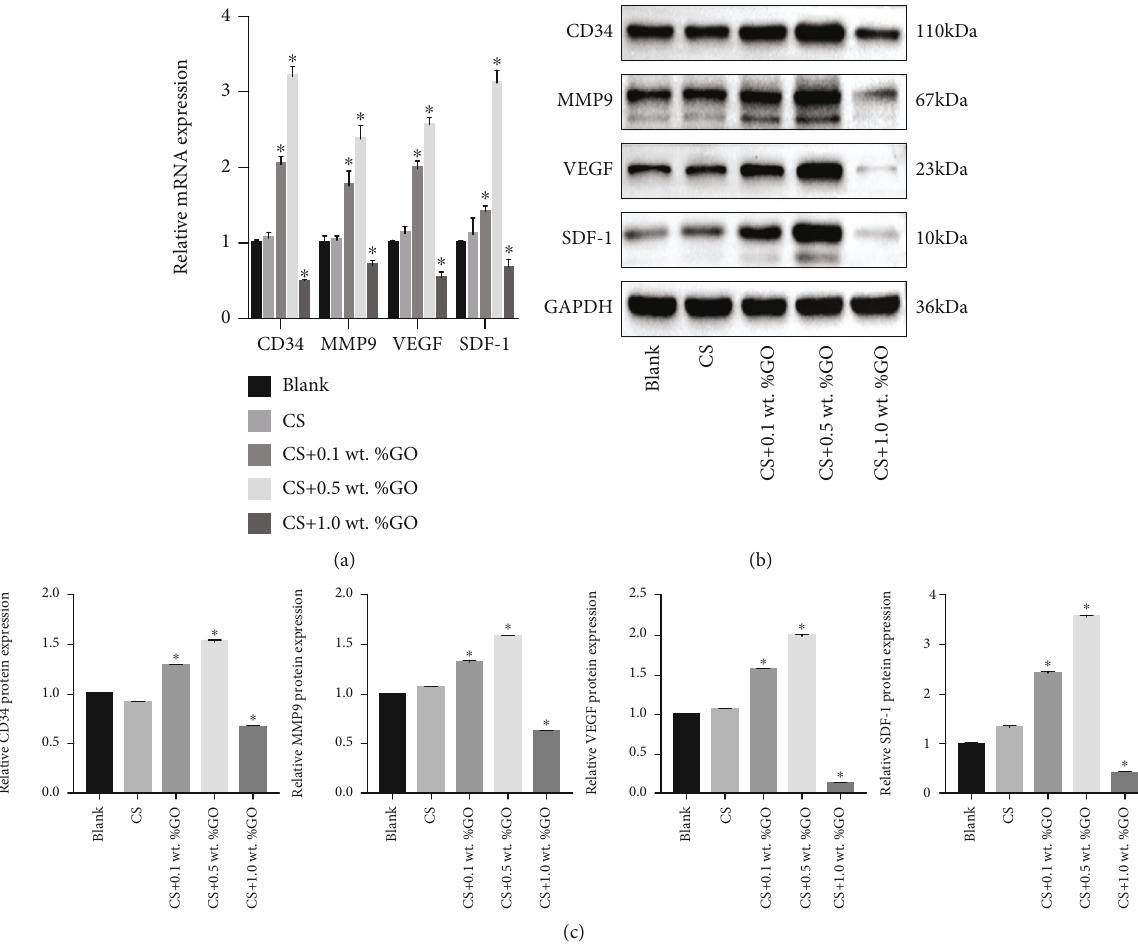
Figure 7: (a) qRT-PCR analysis of the CD34, VEGF, MMP9, and SDF-1 expressions in each group. (b) Western blot analysis results of CD34, VEGF, MMP9, and SDF-1 protein expressions in each group. ∗ P < 0 : 05 compared with the blank